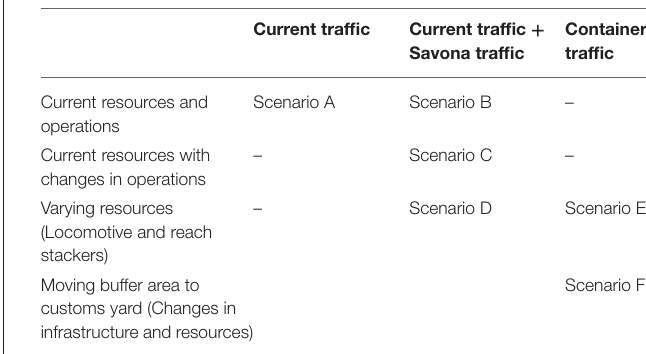
TABLE 2 | Analyzed scenarios with respective changed